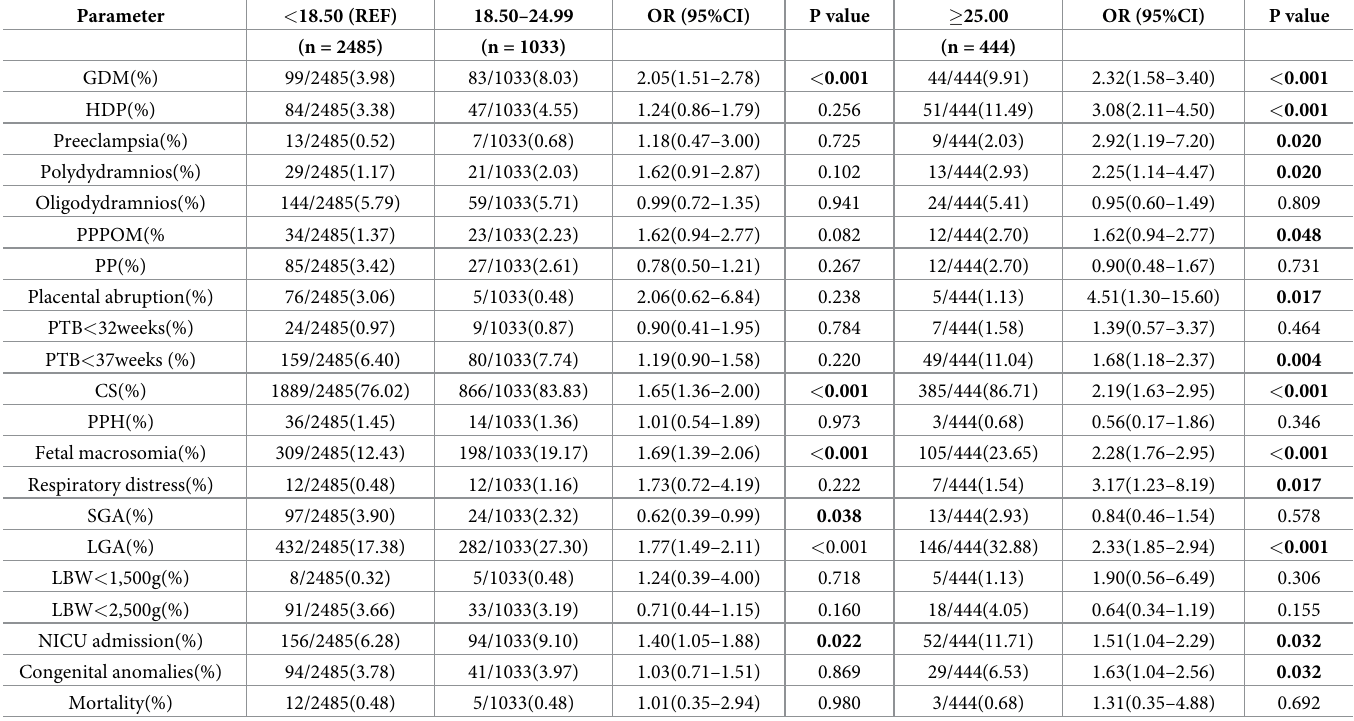
Table 3. Adjusted association between BMI and adverse perinatal outcomes. (adjusted for age, PCOS, parity and type of COH).